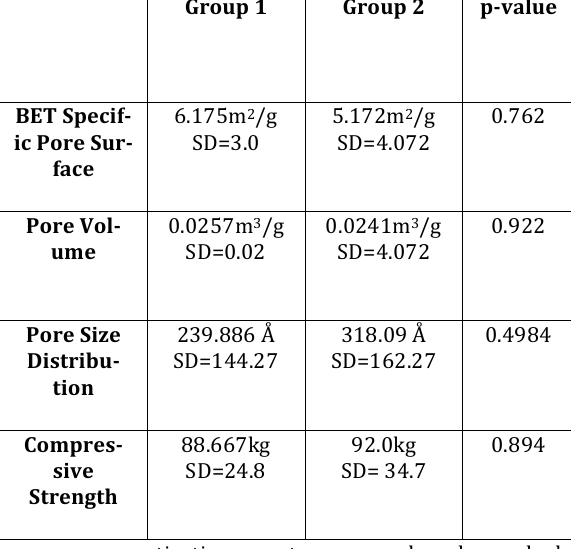
Table 1: Average v alues of group 1 and group 2